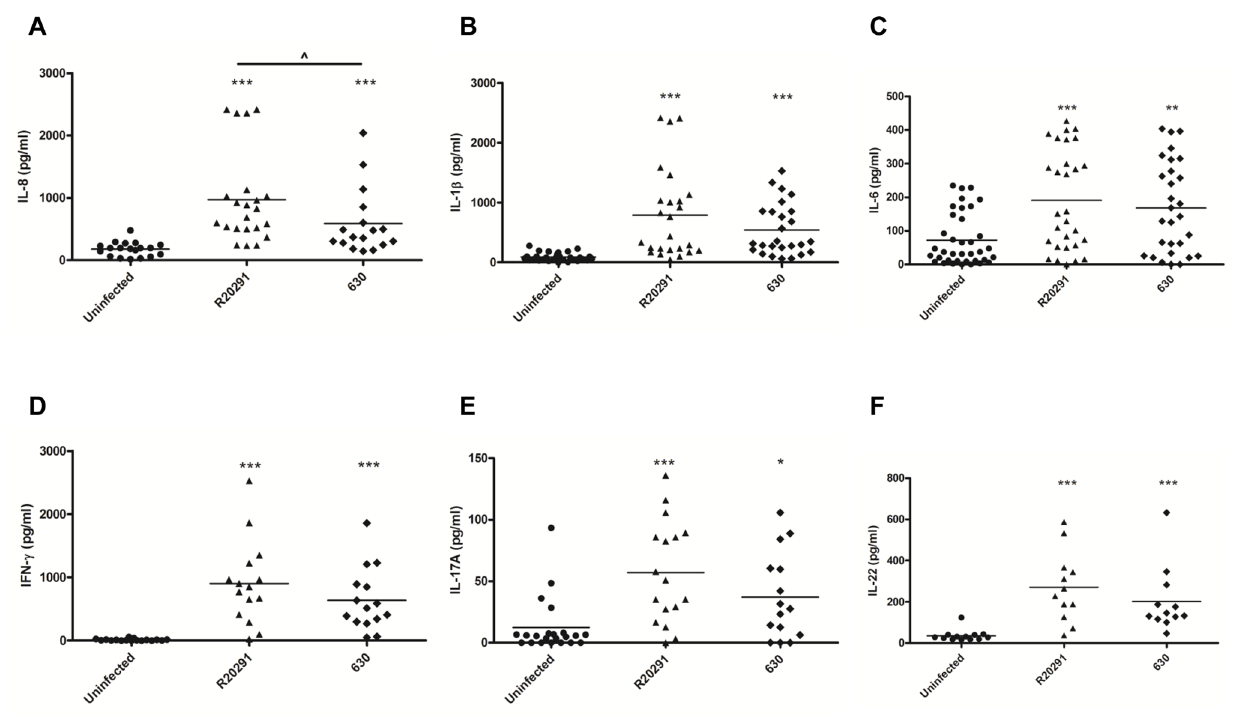
Figure 1. Ex-vivo mucosal cytokine responses to C.difficile infection. Macroscopically normal and matched multiple colonic biopsies (30 individuals with mean age of 10.4 6 SD of 4.7) were infected with C. difficile strains R20291 and 630 (5 6 10 8 ) for 6h. Post-infection IL-8 (A), IL-1 b (B), IL- 6 (C), IFN- c (D), IL-17A (E) and IL-22 (F) were quantified by ELISA. Bars represent median levels. *p , 0.05, **p , 0.01 and ***p , 0.001 represent significant difference from uninfected controls and ˆ p , 0.05 represent significant inter-strain difference. Data was analysed using a Mann–Whitney U test.